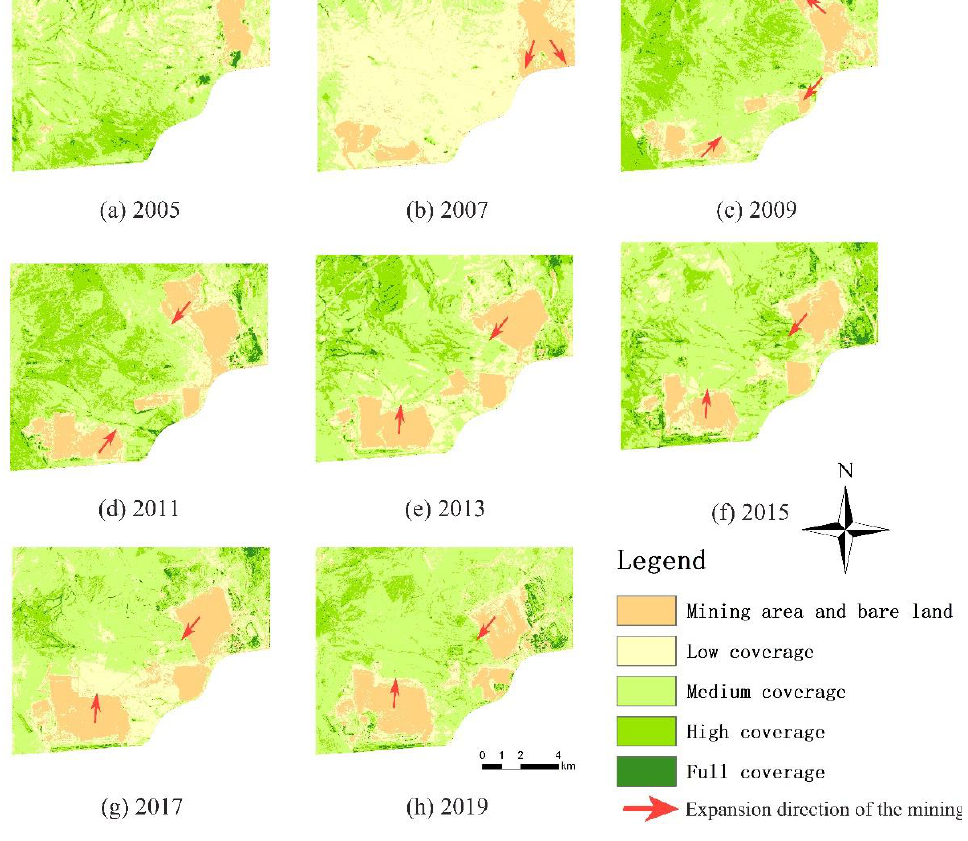
Figure 5. Vegetation coverage in the study area from 2005 to 2019. ( a ) Vegetation coverage in 2005 ( b ) Vegetation coverage in 2007 ( c ) Vegetation coverage in 2009 ( d ) Vegetation coverage in 2011 ( e ) Vegetation coverage in 2013 ( f ) Vegetation coverage in 2015 ( g ) Vegetation coverage in 2017 ( h ) Vegetation coverage in 2019.